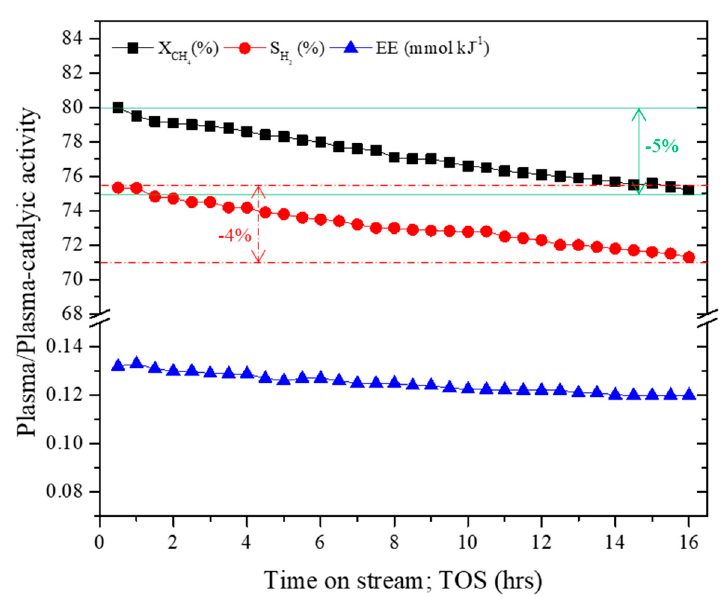
Figure 9. Analysis of time on stream (TOS) (16 h) on X CH4 (%), S H2 (%) and EE mmol kJ − 1 . Experimental conditions: GHSV = 364 h − 1 , specific input energy (SIE) = 300 J mL − 1 , loading of catalyst = 0.5 g, T = 350 ◦ C, discharge gap (D gap ) = 03 mm, discharge length (D L ) = 20 cm, discharge volume (V D ) without catalyst: 13.5 cm 3 , V D with catalyst loading = 9.75 cm 3 .